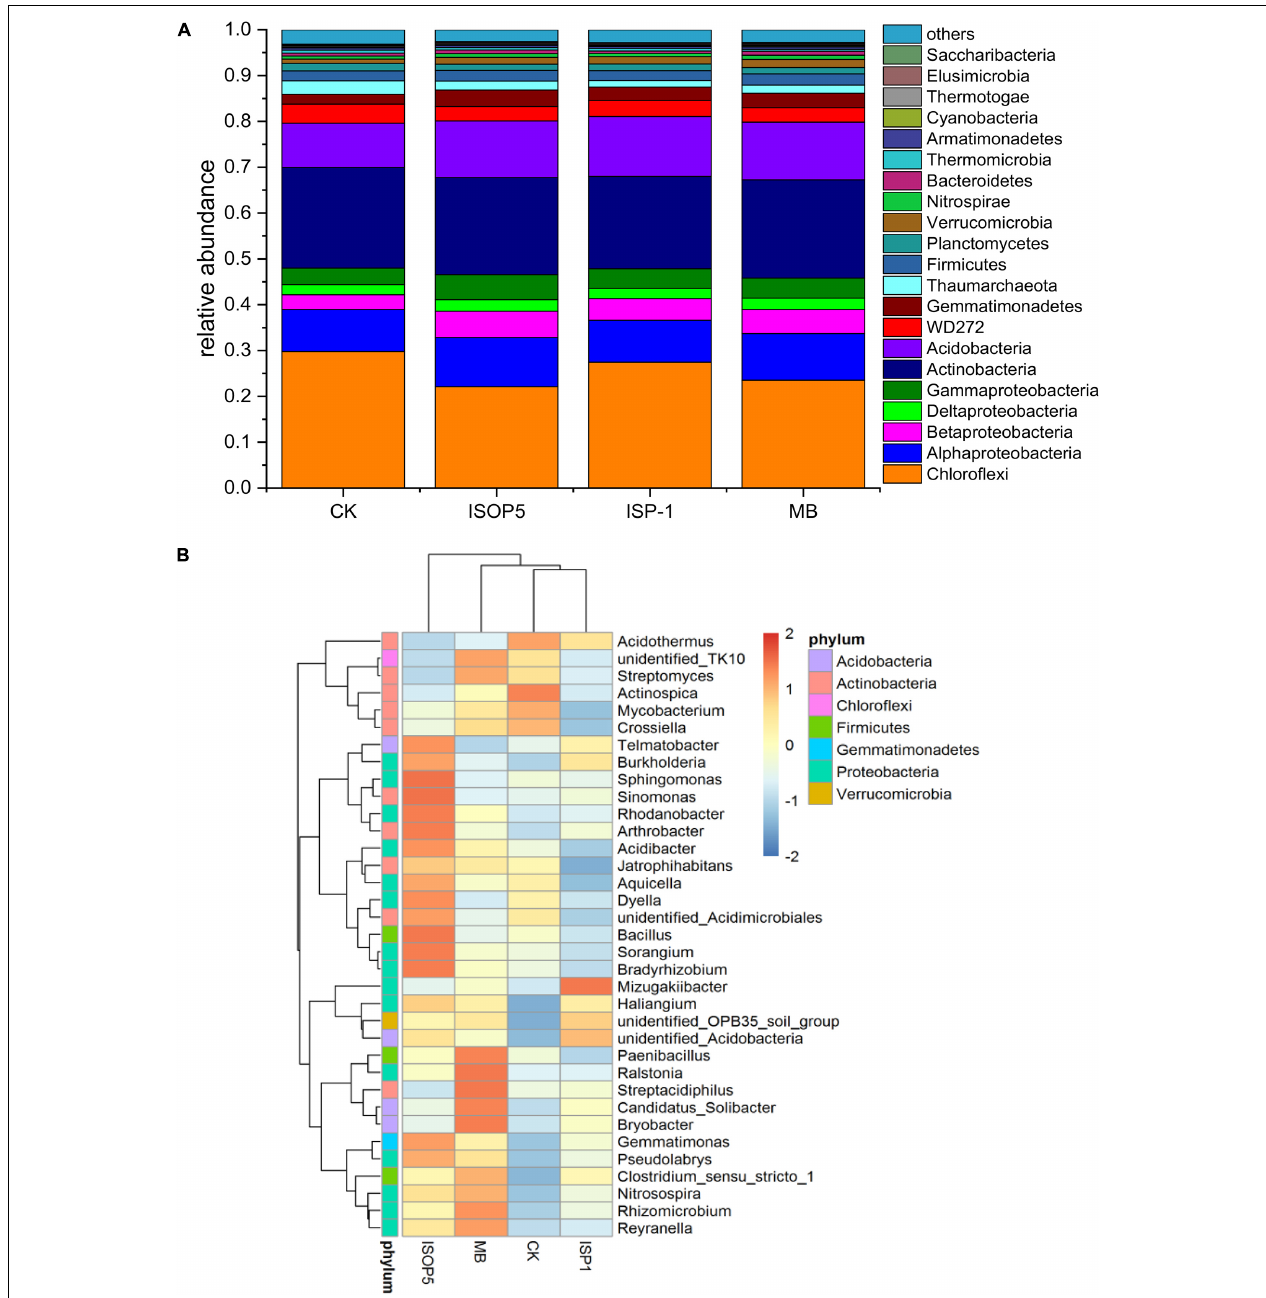
FIGURE 2 | Relative abundance in the dominant bacterial phyla (proteobacterial classes) (A) and dominant genus (B) in the unique OTUs of each treatment. CK: fertilized with basic fertilizer containing NPK fertilizers and composted cow manure; B. cepacia ISOP5: fertilized with basic fertilizer and then applied with suspension of strain B. cepacia ISOP5; R. palustris ISP-1 : fertilized with basic fertilizer and then applied with suspension of strain R. palustris ISP-1; MB: fertilized with basic fertilizer and then applied with suspensions of B. cepacia ISOP5 and R. palustris